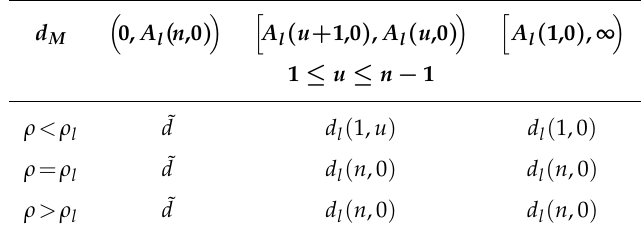
Table 10. Optimal solutions d (cid:63) n with respect to ρ and d M for v = n . The vectors for ρ = ρ l are representative optimal